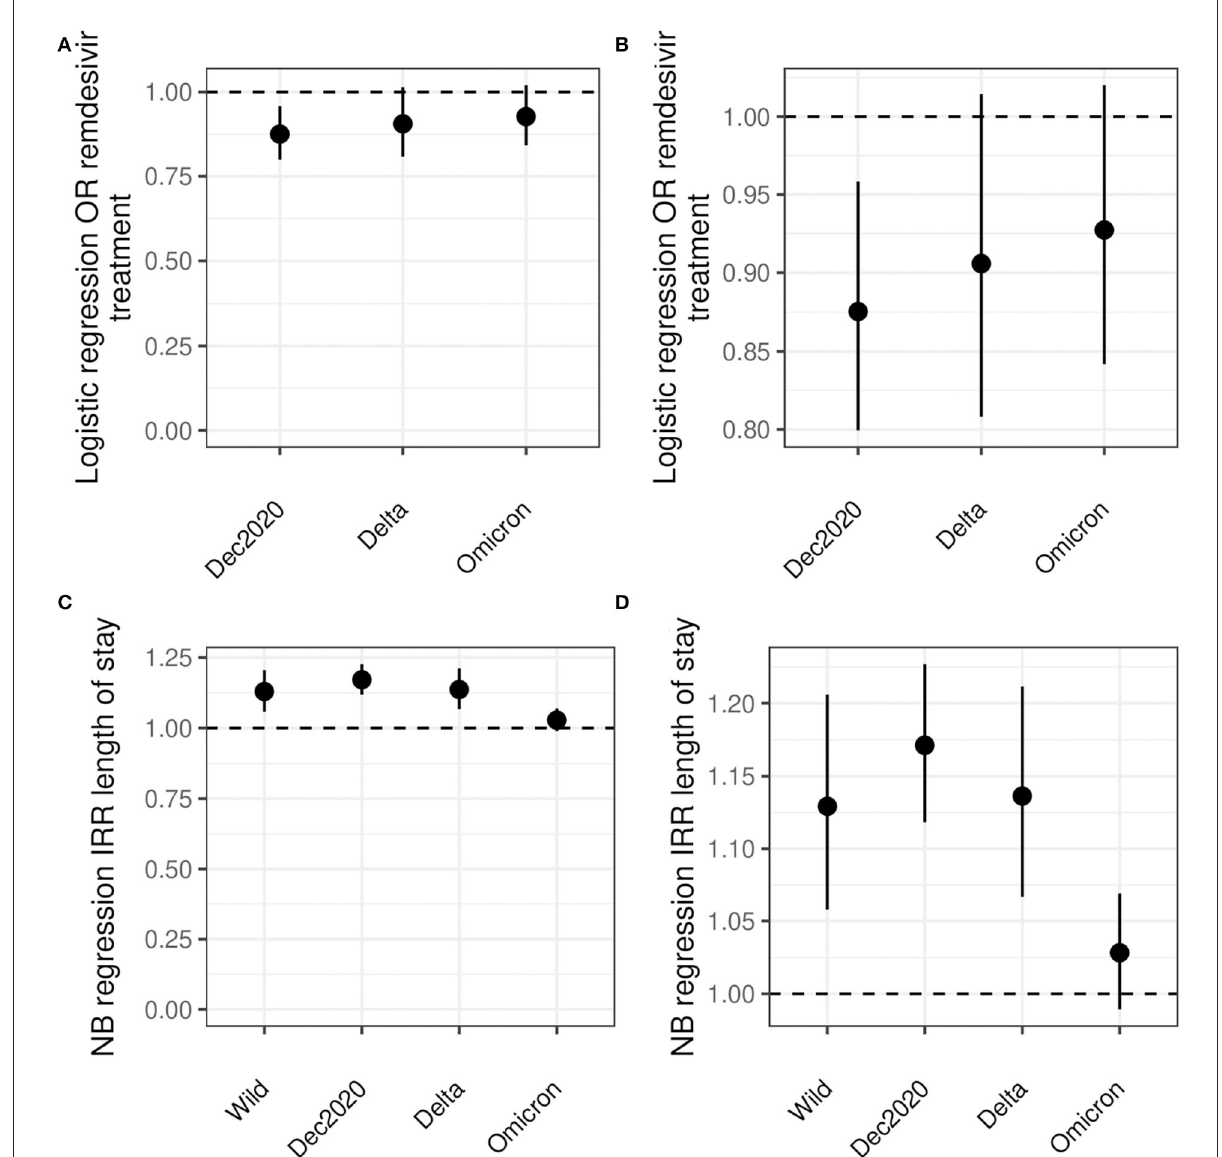
FIGURE3 Logistic and NB regression results. (A, B) show the odds ratio for remdesivir treatment comparing Black and White inpatients. (C, D) show the risk ratio for LoS comparing Black and White inpatients. All analyses are adjusted for age, sex, diabetes, hypertension, CKD, liver disease, immunocompromised state, and cancer. Note the differences in y-axes between (A, C) and between (B, D) .